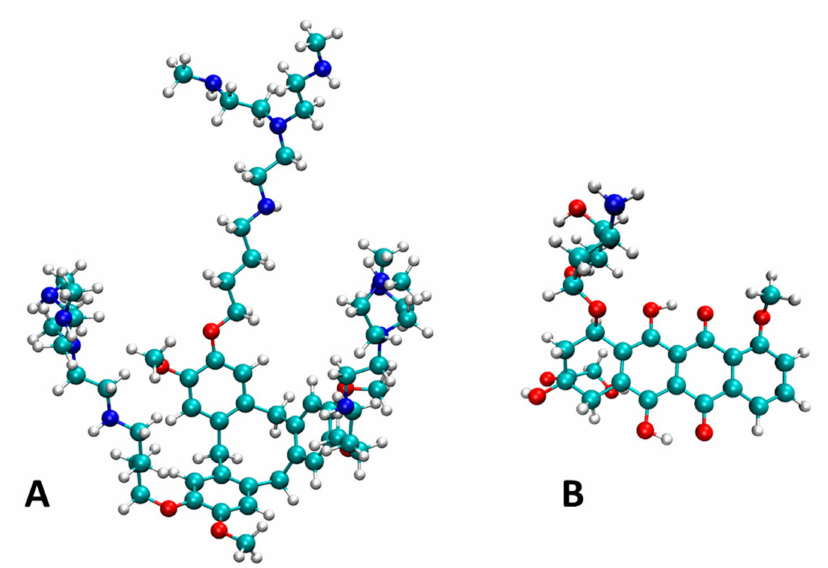
Figure 7. Density functional theory (DFT) optimized structure of ( A ) ethyleneimine–CTV copolymer unit and ( B ) doxyrubicin molecule in ball and stick representation (cyan is carbon, white is hydrogen, red is oxygen, and blue is